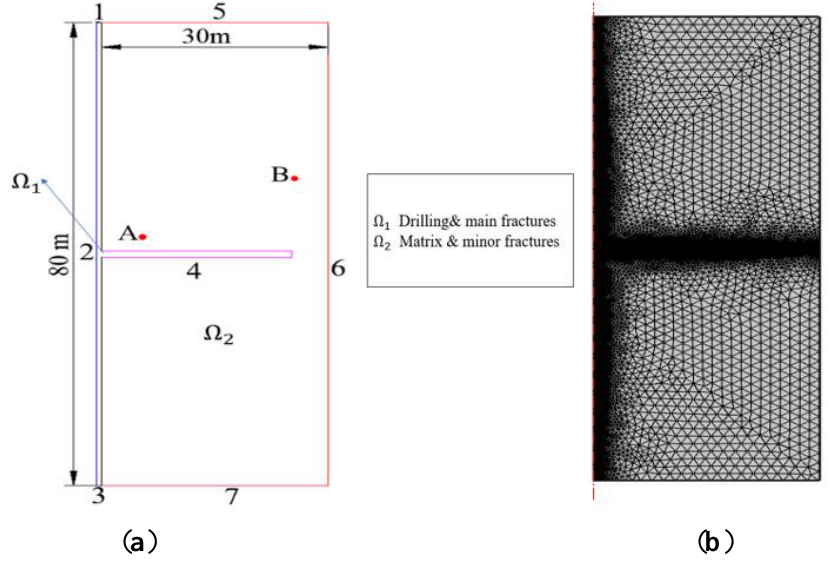
Figure 3. (a) Geometric and (b) meshing model. Figure 3. ( a ) Geometric and ( b ) meshing